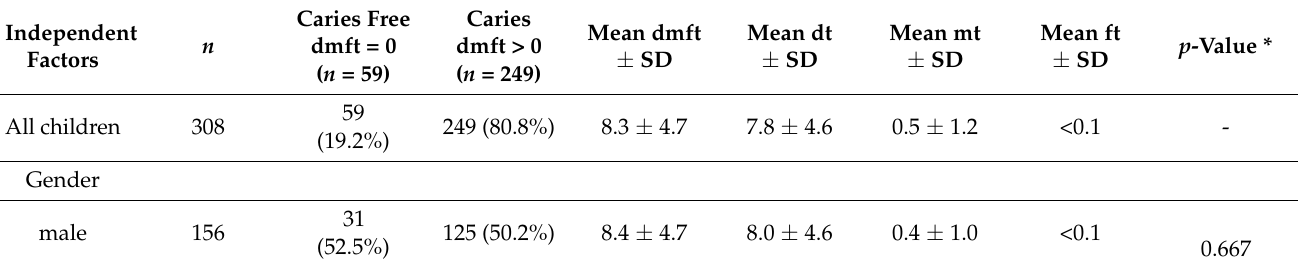
Table 1. Prevalence and severity of dental caries in the study children. Independent Factors